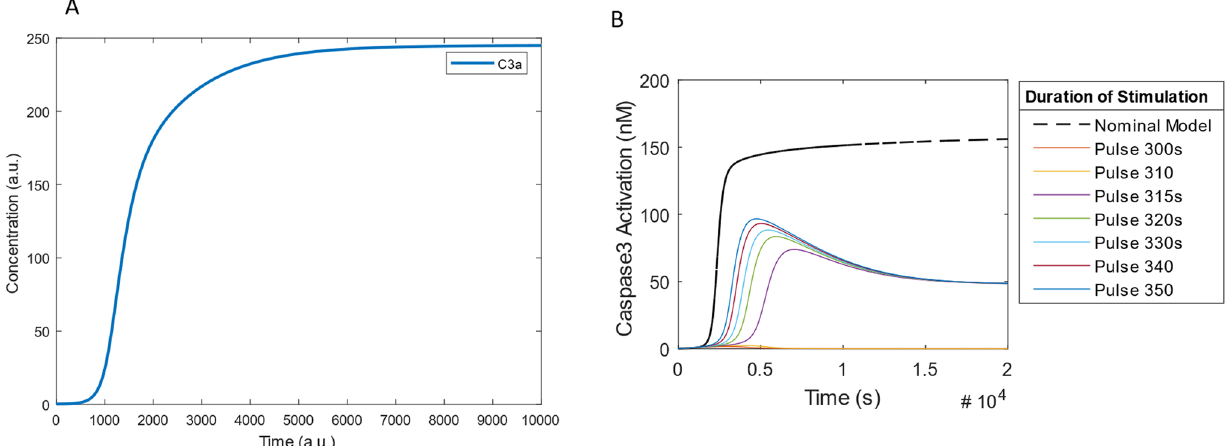
Figure 2. Investigating Model Behaviour. ( A ) Time course of activation of caspase 3 under constant stimulation. BAX was activated upon application of stimulus, u (0.5 nM). The time course demonstrates that the model simulation of caspase 3 activation is in accordance with experimental results—that caspase 3 is activated within 15 min following initiation 14 . ( B ) Time course of caspase 3 activation in response to transient pulse stimulation. Upon stimulation of BAX by u (0.5 nM) for 300 s, caspase 3 does not become activated. When a pulse stimulation of u (0.5 nM) for 315 s was applied, caspase 3 was activated to ~ 50% of nominal model caspase